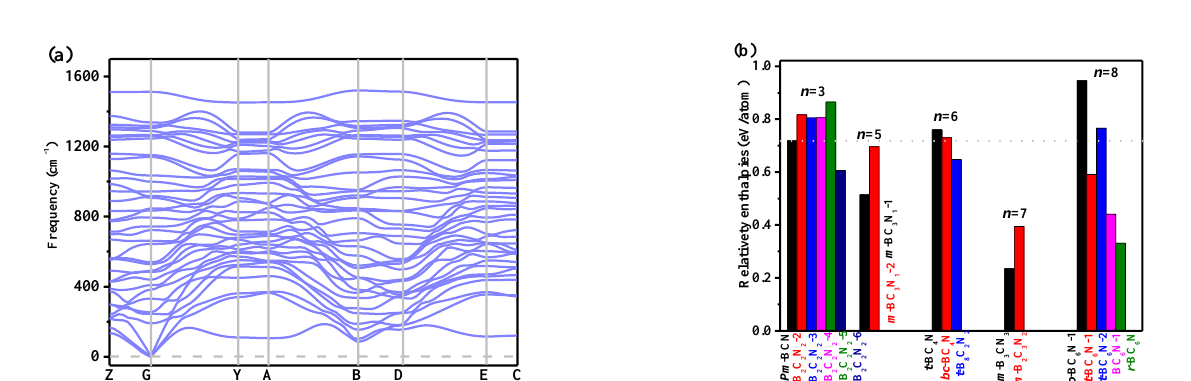
Figure 2. Phonon spectra of Pm -BCN ( a ) and the relative enthalpies of B-C-N compounds ( b ). Young’s modulus E is calculated by E = 9 BG /(3 B + G ), and Table 2 lists the calculated elastic moduli of B-C-N compounds. The elastic moduli of Pm -BCN are less than those of other B-C-N compounds, and larger than those of other light element compounds, such as Pnc 2 BN [23], P 4/ m BN [26], P 2 1 3 BN [40], B 2 C 3 [41], dz4 BN [42],